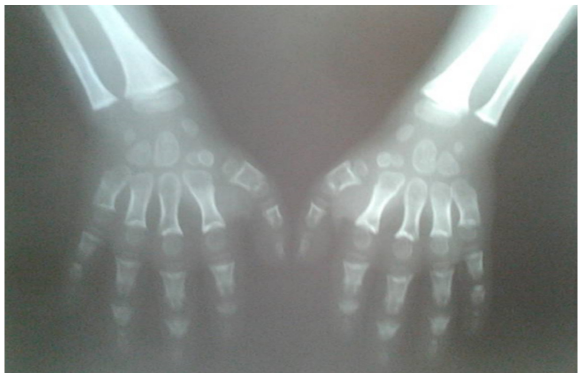
Figure 1. Radiographs of hands (10 years of age) revealed brachydactyly; wide and shortened phalanges of the fingers, cone-shaped epiphyses of phalanges, short metacarpals.